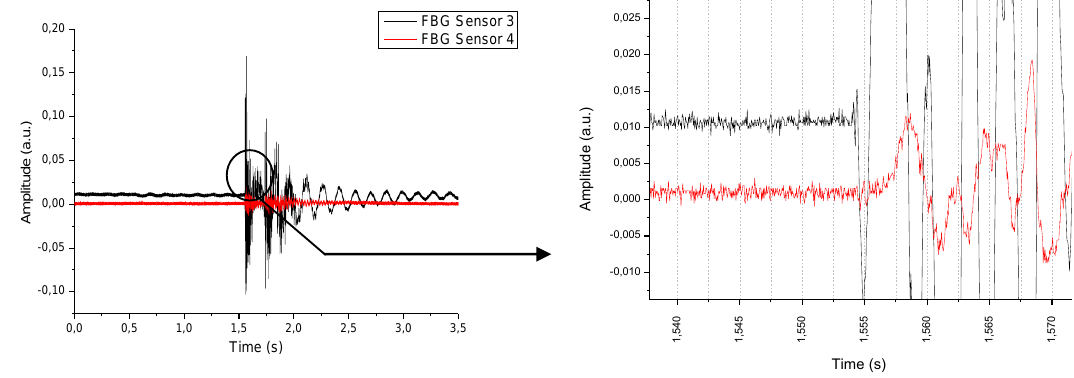
Figure 9. Detail of the wavefronts received by each sensor (Impact point 3, Fiber Bragg Gratings 3 and